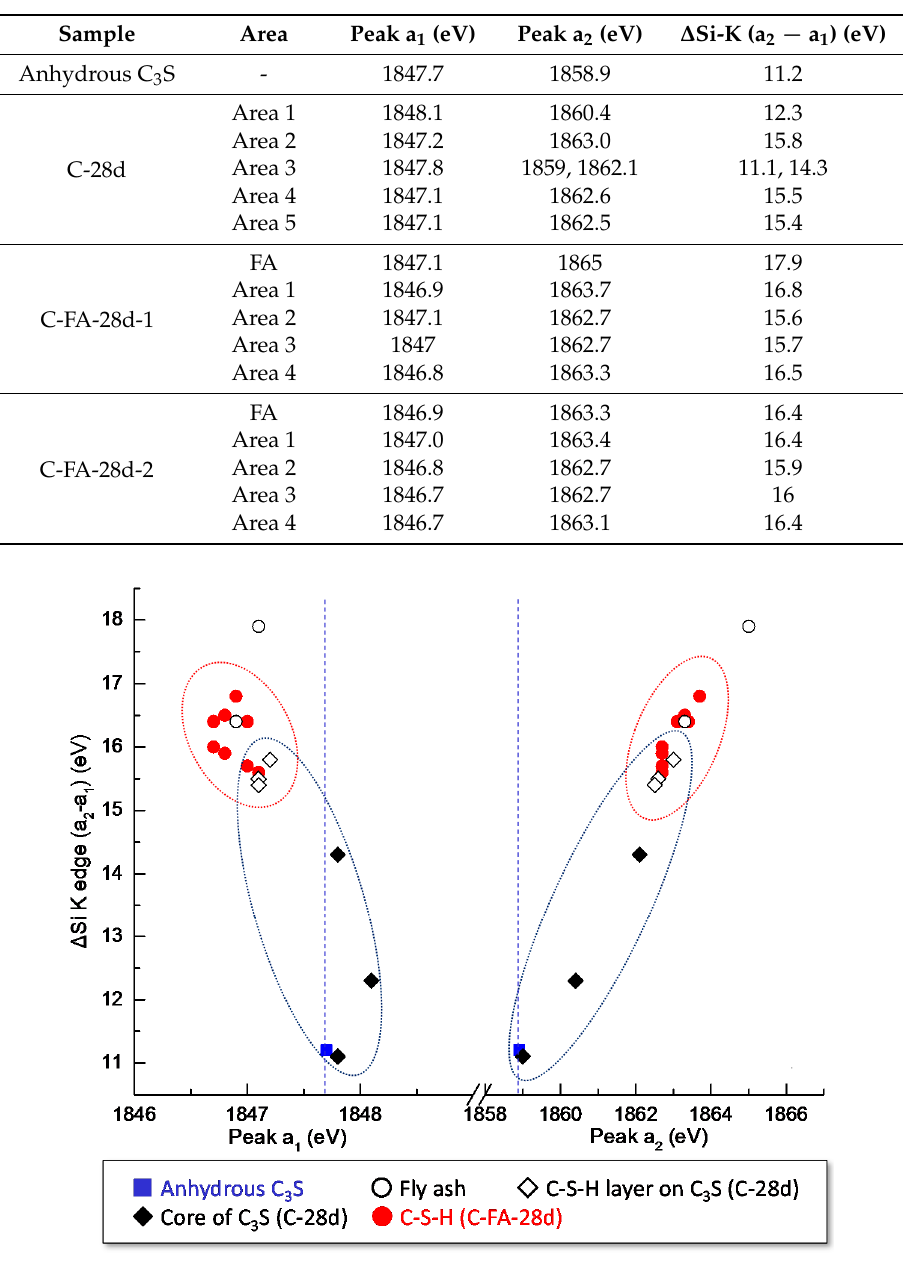
Figure 10. Relationship between the peak positions (a 1 and a 2 ) and the energy separation values (a 2 − a 1 ) in the selected areas of C-28 and C-FA-28d. The energy resolution of the spectrum is ±0.1 eV. Peak positions and separation values used for plotting are tabulated in Table 2.